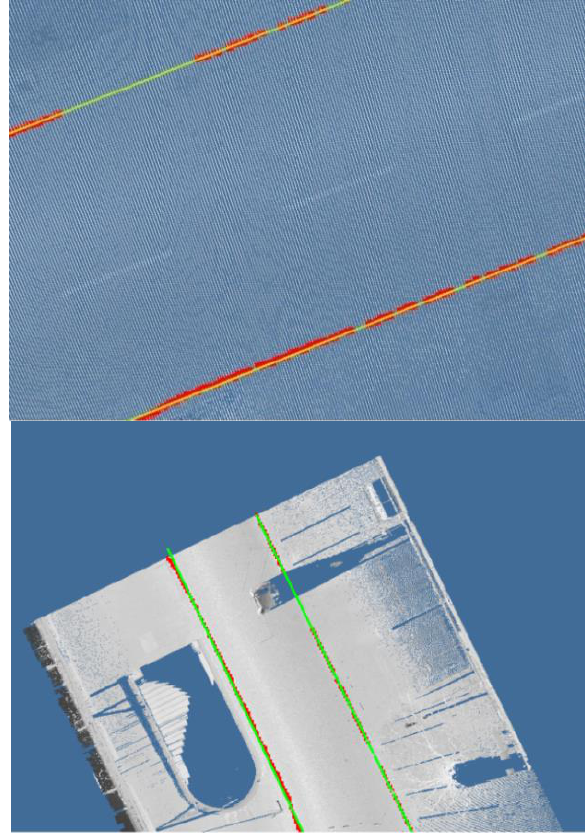
Figure 8. Result of curbstone edge detection and vectorisation (green straight-lines)